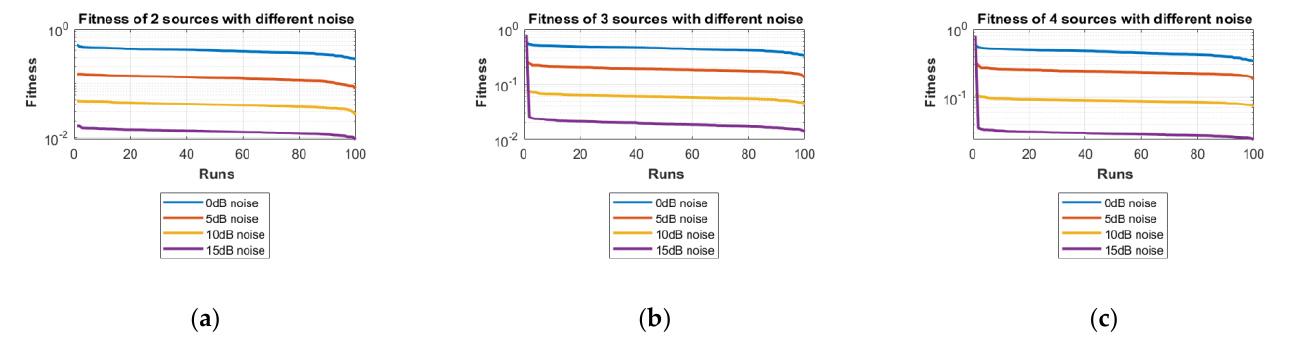
Figure 8. Fitness with Different Noises: ( a ) Two Sources; ( b ) Three Sources; ( c ) Four Sources.